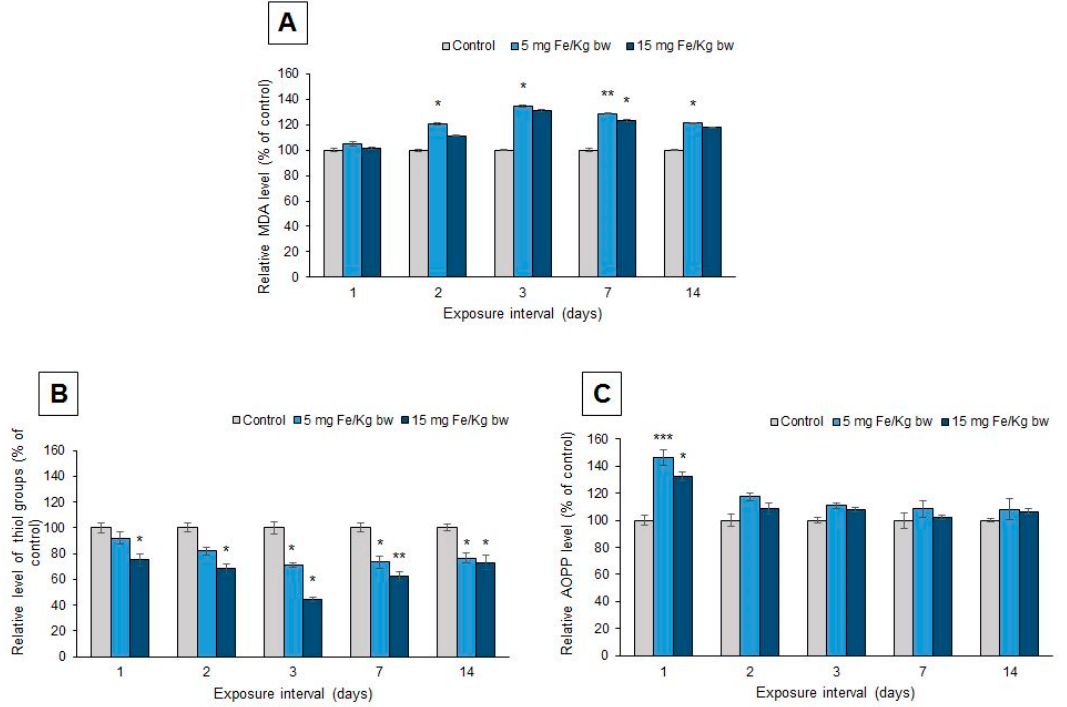
Figure 8. Effect of MNP-DSPE-PEG in the liver of CD1 mice on ( A ) malondialdehyde (MDA), ( B ) protein thiol groups (P-SH), and ( C ) advanced oxidation protein products (AOPP) levels up to 14 d. The results were expressed as mean ± standard deviation (SD) and represented as percentages related to the control group; the data were considered statistically significant when *p < 0.05; **p < 0.01; ***p < 0.001 versus the control group.